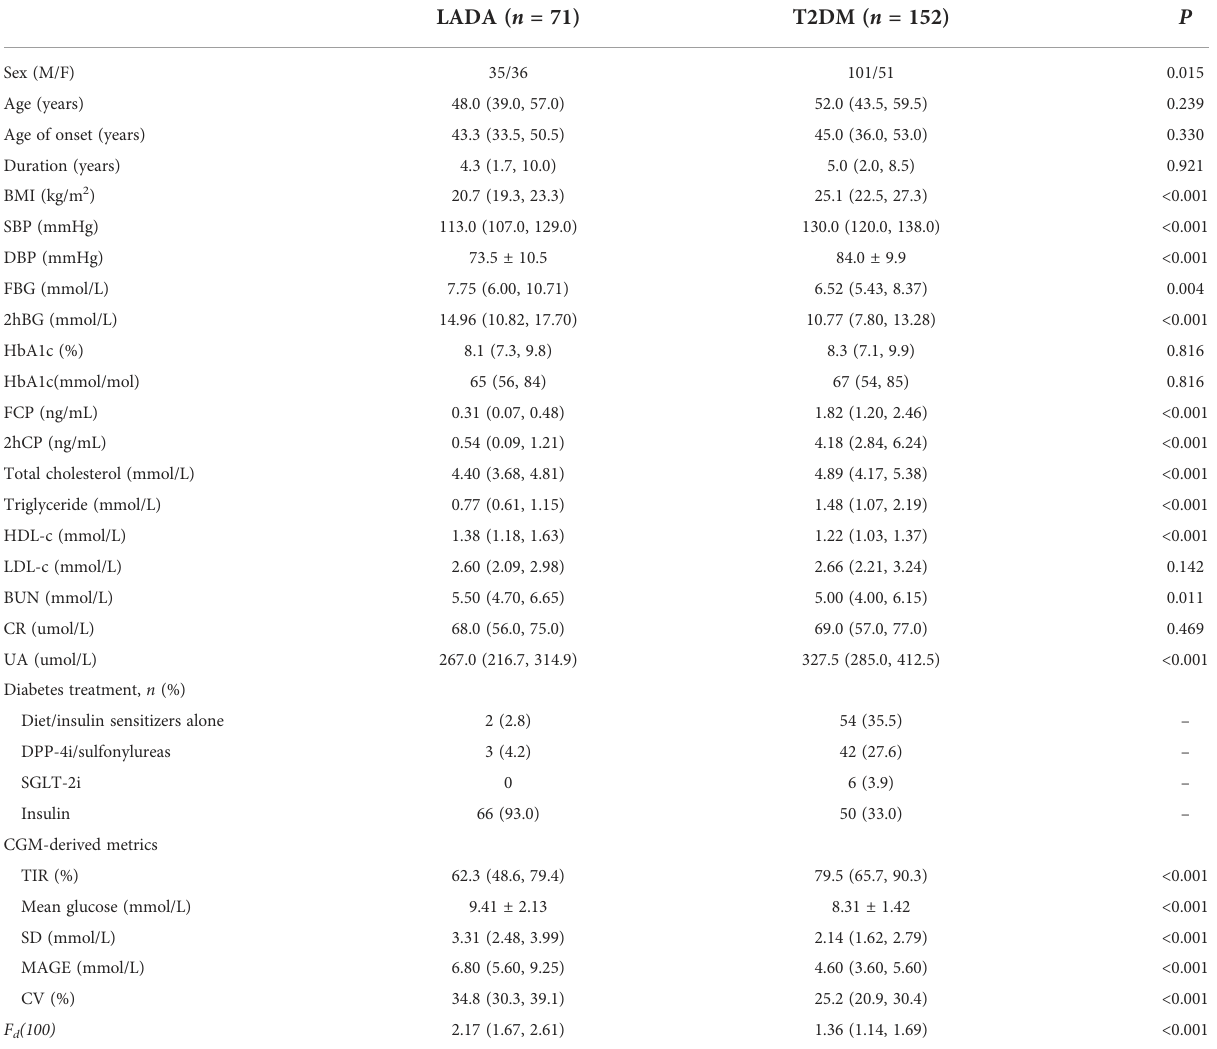
TABLE 1 Characteristics of all participants.